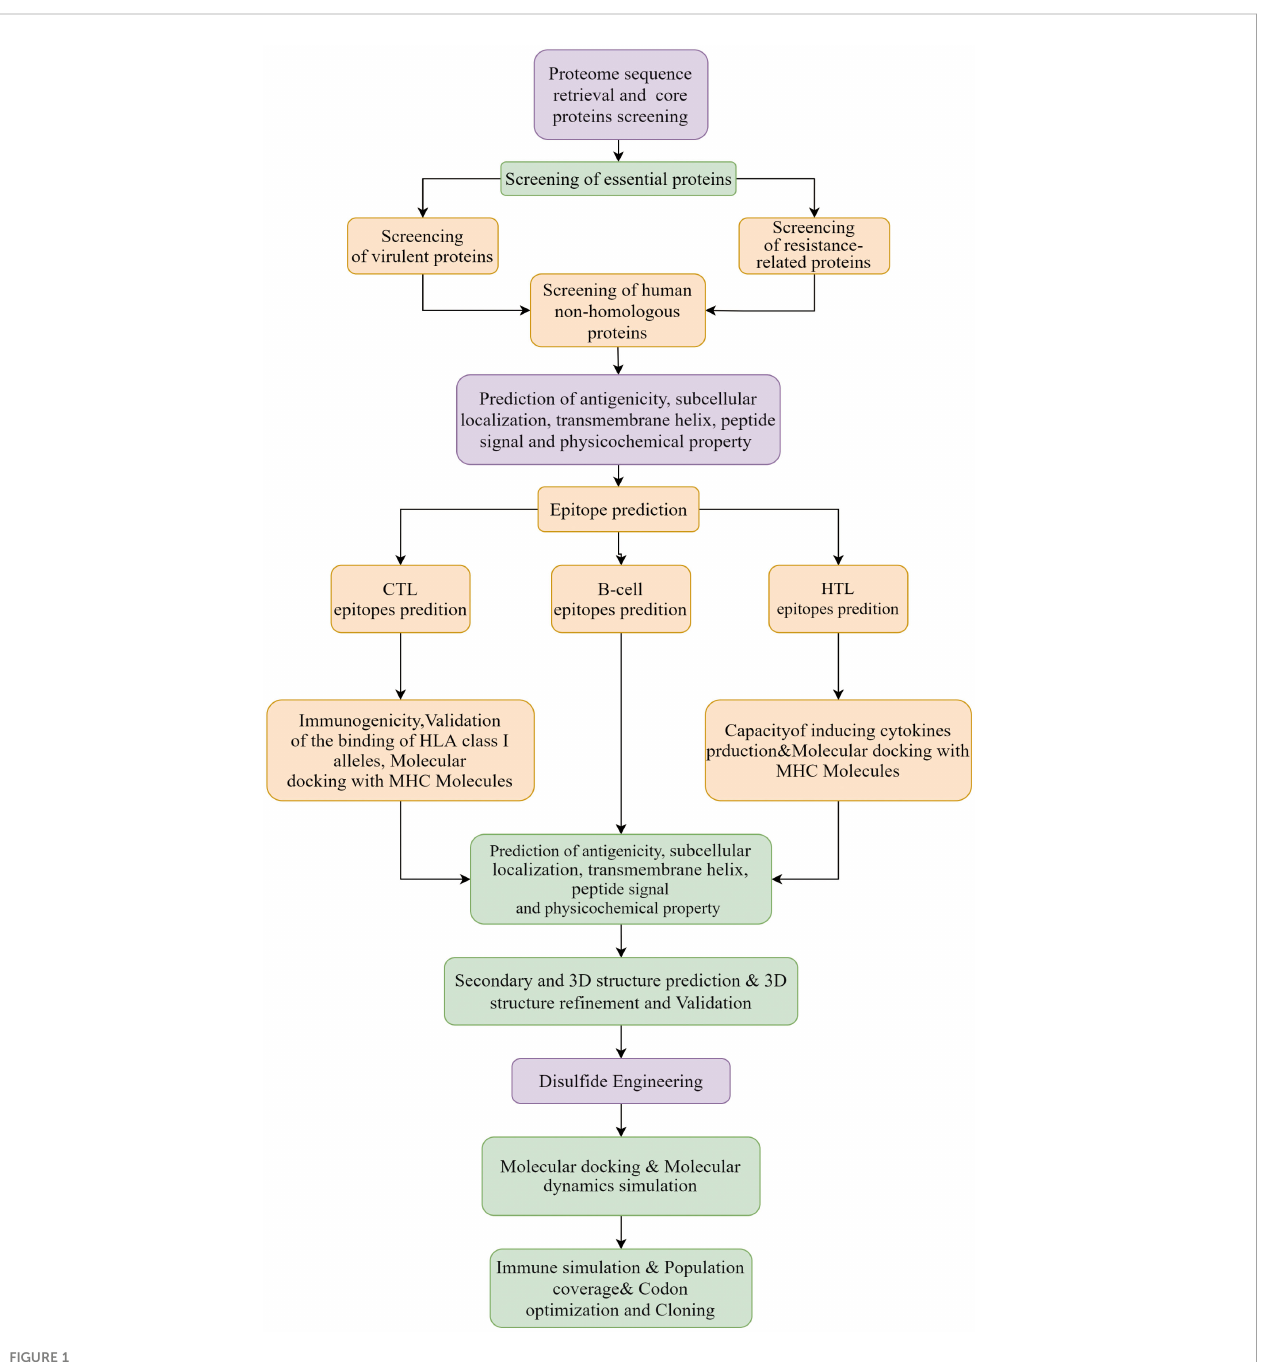
FIGURE 1 Work fl ow designed for 6 common Nocardia subspecies